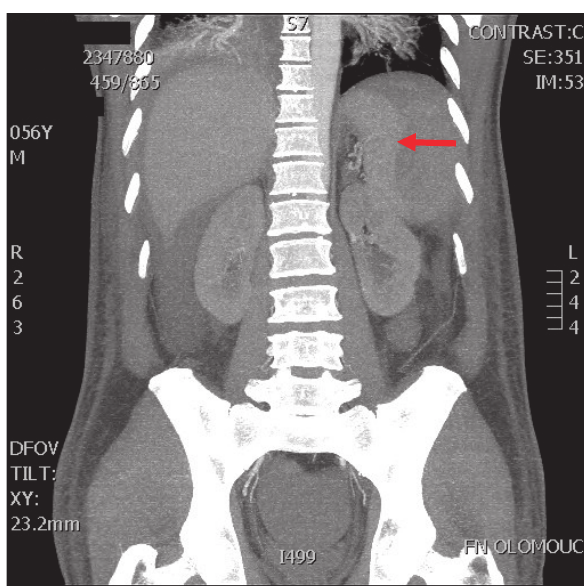
Fig. 3. Abdominal CTA showing SSR with large intraparenchy- mal haematoma (red arrow). Large intraparenchymal hematoma of the spleen was detected by CTA with no signs of active bleeding into the peritoneal cavity.